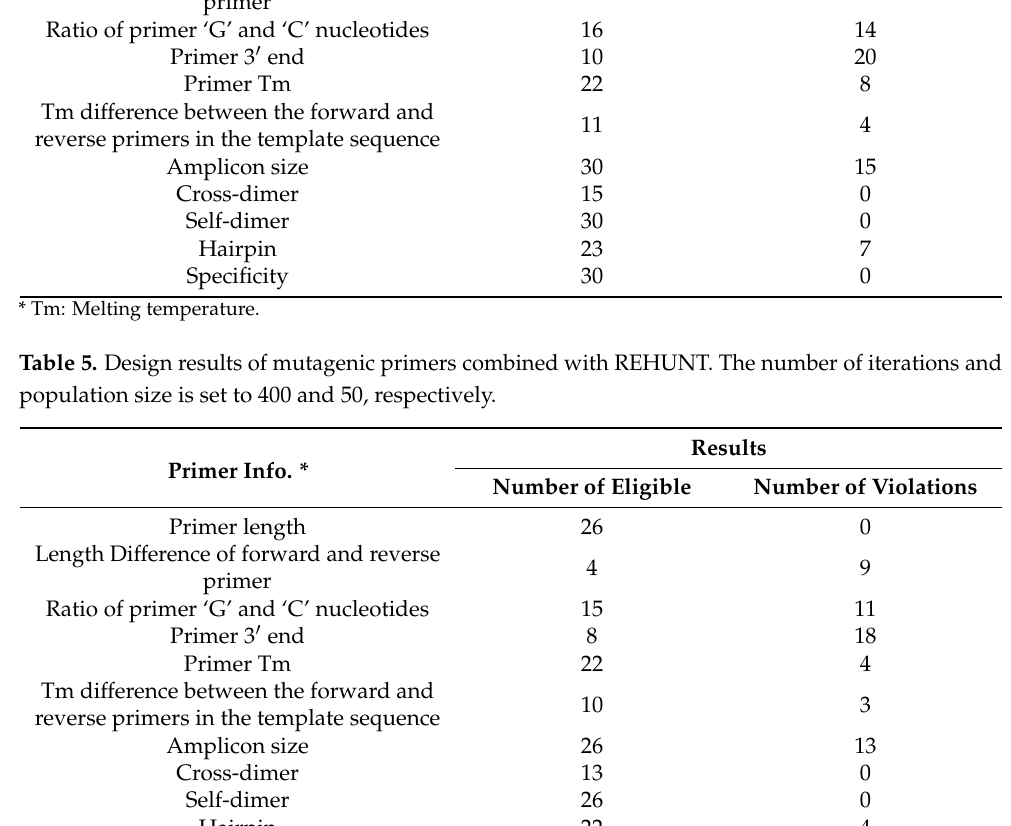
Table 4. Design results of mutagenic primers combined with REHUNT. The number of iterations and population size were set to 300 and 50, respectively. Results Primer Info. * Number of Eligible Number of Violations Primer length 30 0 Length difference of forward and reverse primer